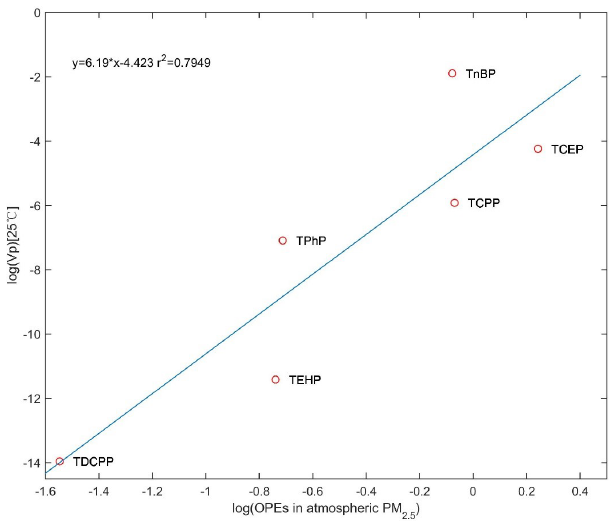
Figure 4. Relationship of individual OPE concentration in PM 2 . 5 and its vapor